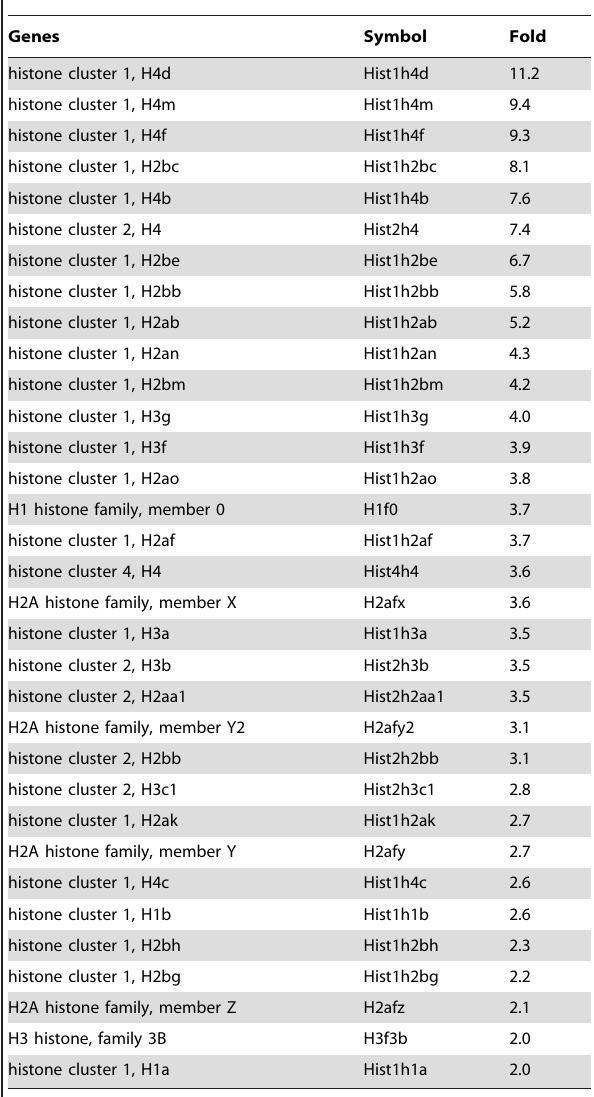
Table 10. Gene expression changes of centromere protein and chromosome structural genes in lal 2 / 2 bone marrow